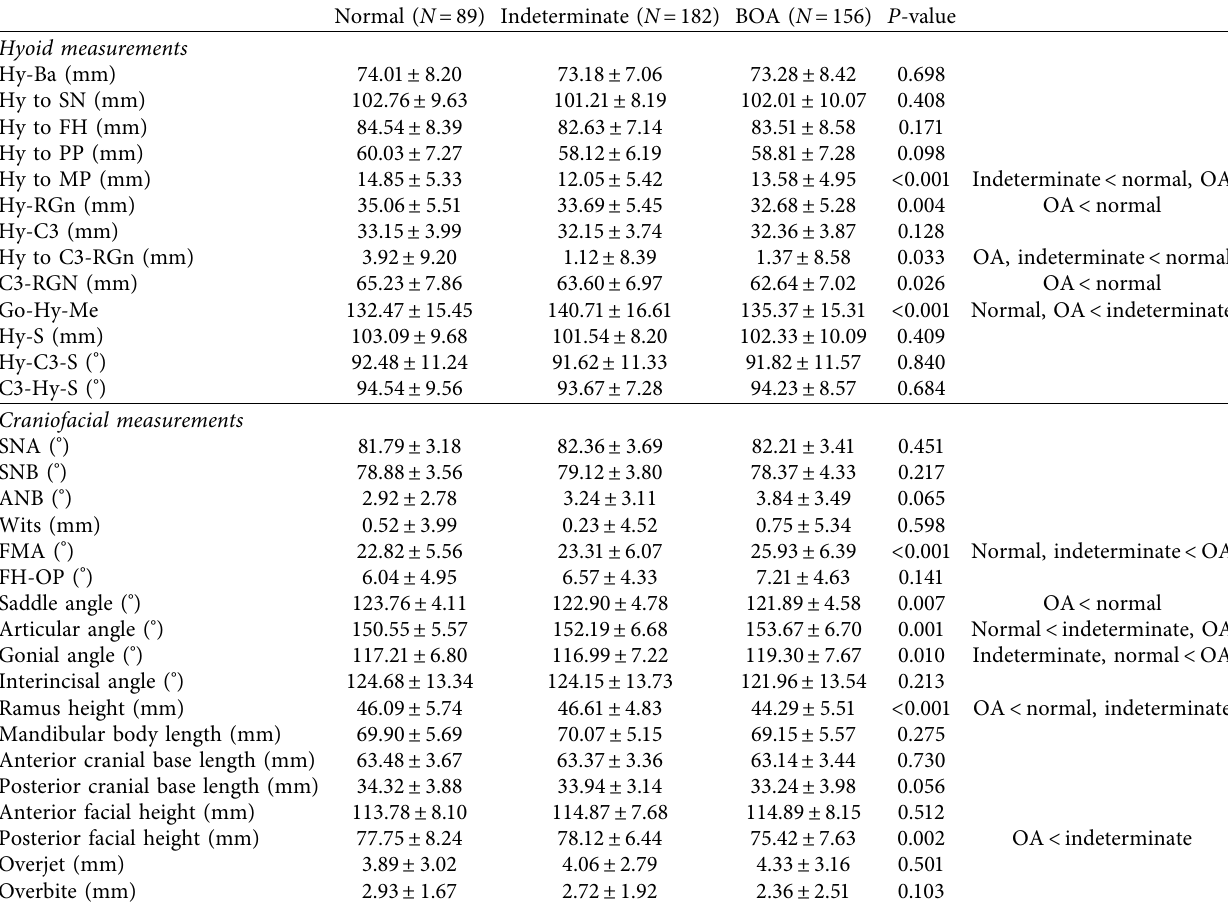
Table 3: Differences in hyoid and craniofacial measurements among the three groups.